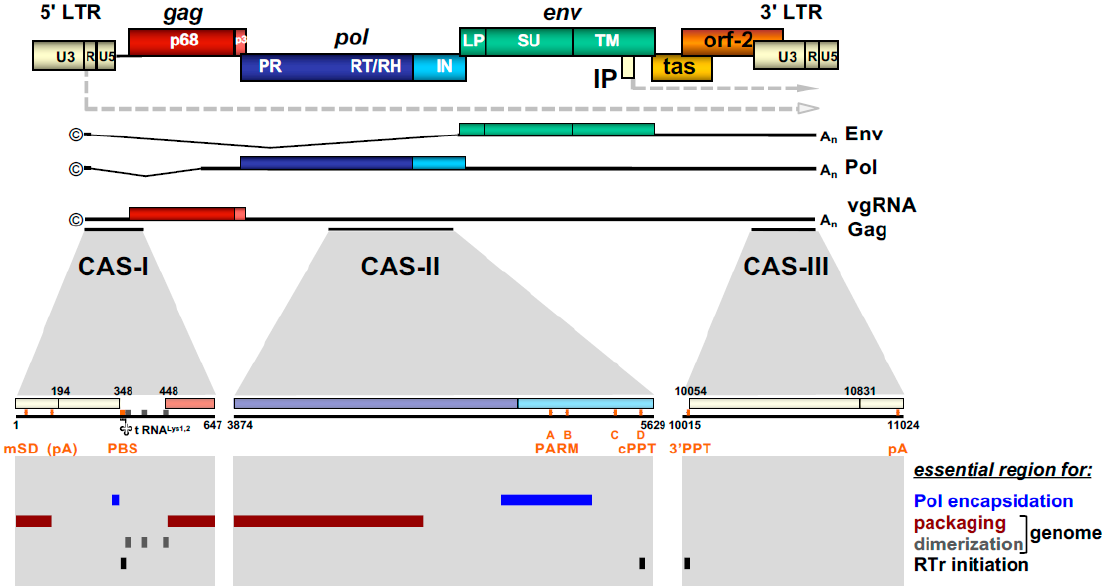
Figure 3. FV provirus organization, genomic and structural gene transcripts, and essential cis-acting viral RNA sequence elements. Schematic illustration of the PFV proviral DNA genome structure with long terminal repeats (LTRs) and open reading frames (ORFs) indicated as boxes. For ORFs encoding Gag, Pol, and Env precursor proteins, the regions encompassing the mature subunits generated by proteolytic processing are indicated by different colors and are labeled accordingly. Transcription initiation sites in the LTR and internal promoter (IP) and direction of transcription are indicated by dashed line arrows. Spliced and unspliced viral transcripts originating from the LTR and encompassing the viral RNA genome (vgRNA) or encoding the structural proteins Gag, Pol, and Env are schematically illustrated below and their respective coding capacity indicated to the right. Transcripts originating at the IP are omitted. Cis-acting sequence (CAS) elements localized within the full-length viral RNA genome, which are essential for viral replication, are indicated by black bars underneath the vgRNA. Individual functionally important or essential RNA sequence motifs are marked in the enlarged individual CAS elements below. Numbers represent nucleotide positions of the viral PFV RNA genome (HSRV2 isolate). At the bottom, individual regions within the vgRNA, which are essential for specific functions in viral replication as indicated to the right, are marked as differentially colored bars. U3: unique 3 (cid:48) LTR region; R: repeat LTR region; U5: unique 5 (cid:48) LTR region; ©: cap structure; A n : poly A tail; mSD: major splice donor; PBS: primer binding site; PARM: protease activating RNA motif; cPPT: central poly-purine tract; 3 (cid:48) PPT: 3 (cid:48) poly-purine tract; pA: polyadenylation signal; A-D: purine-rich sequence motifs PPT A through D; RTr: reverse transcription; tas: transactivator of spumaviruses; bel-2: between envelope and LTR ORF-2. Adapted from